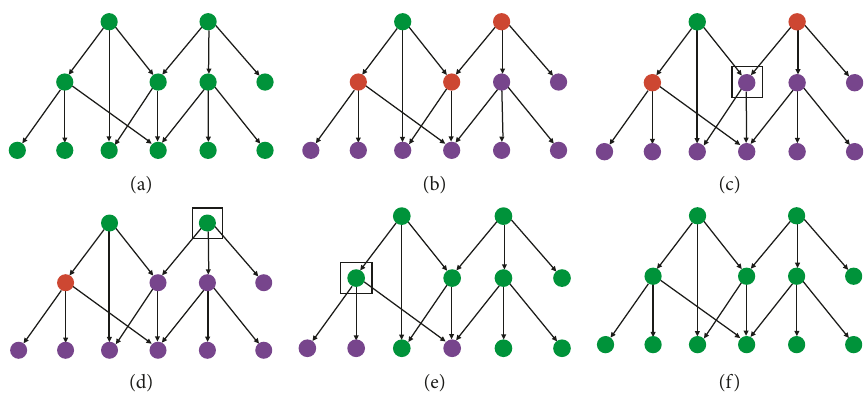
Figure 2: Random recovery strategy. (a) Initial configuration of the system. Green node indicates that the node is active and operates normally. (b) Disruption is generated. Red nodes and purple nodes are the disrupted and disabled nodes, respectively. A node will be disabled when at least one of its upstream nodes is disrupted or disabled. (c) A disrupted node which was chosen randomly is recovered. The rectangle indicates the recovered node. In this case, the node is still inactive since one of its upstream nodes is still disrupted. (d) Another disrupted node was chosen and is recovered. Its downstream nodes will be activated in the next time step. (e) Last disrupted node is recovered. (f) All nodes are recovered and activated.